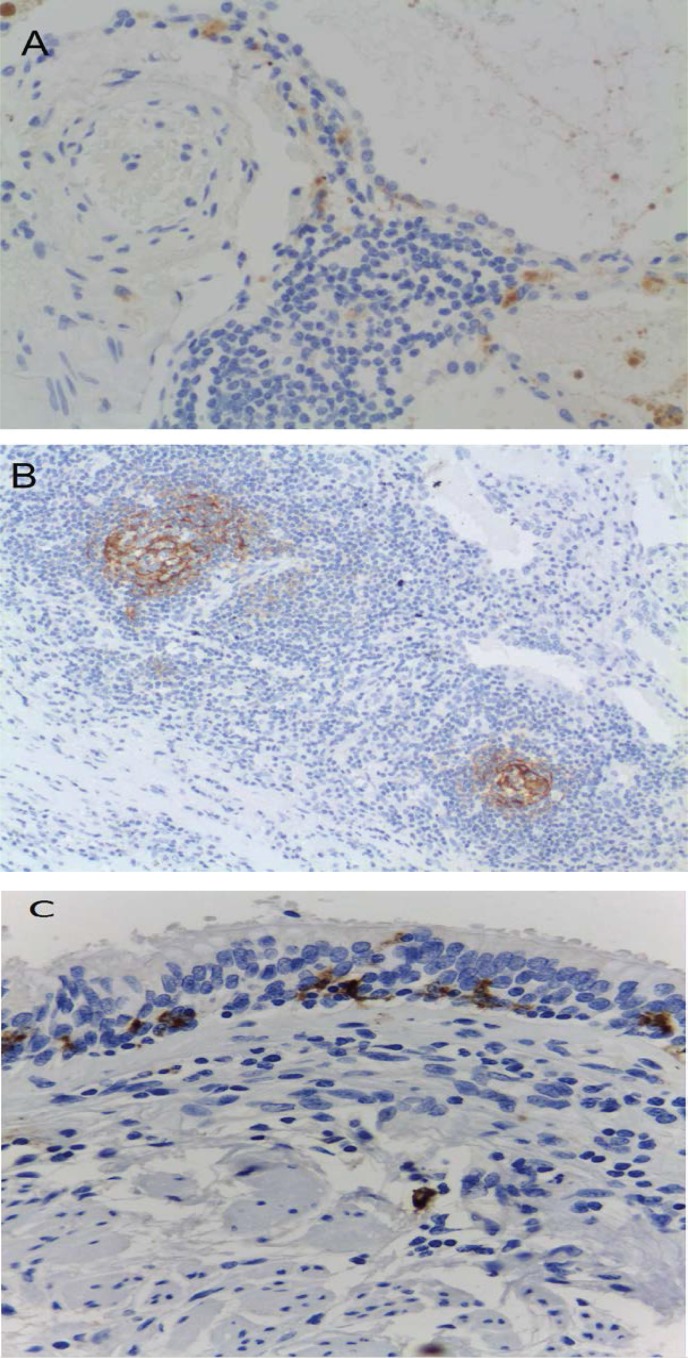
Immunohistochemical staining: CD1a (panel a), CD21 (panel b), and CD207 (panel c).